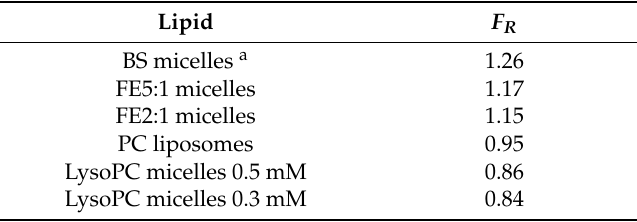
Table 3. Pyrene fluorescence maximum F R = F III / F I